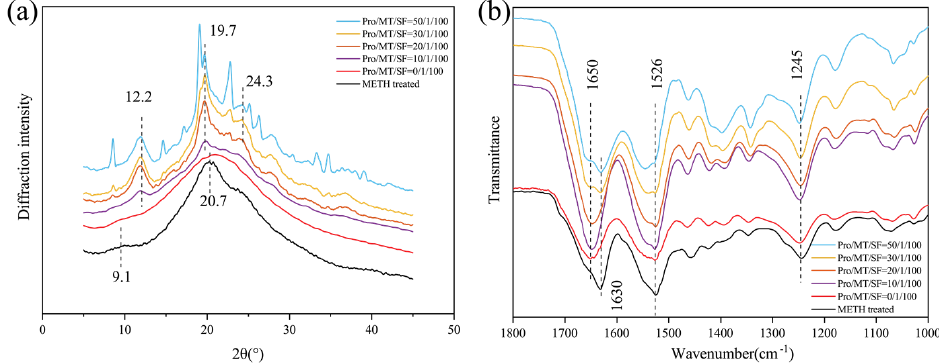
Figure 3. Structural analysis of MT/SF@MNs: ( a ) X-ray diffraction curve, ( b ) infrared absorption spectrum.